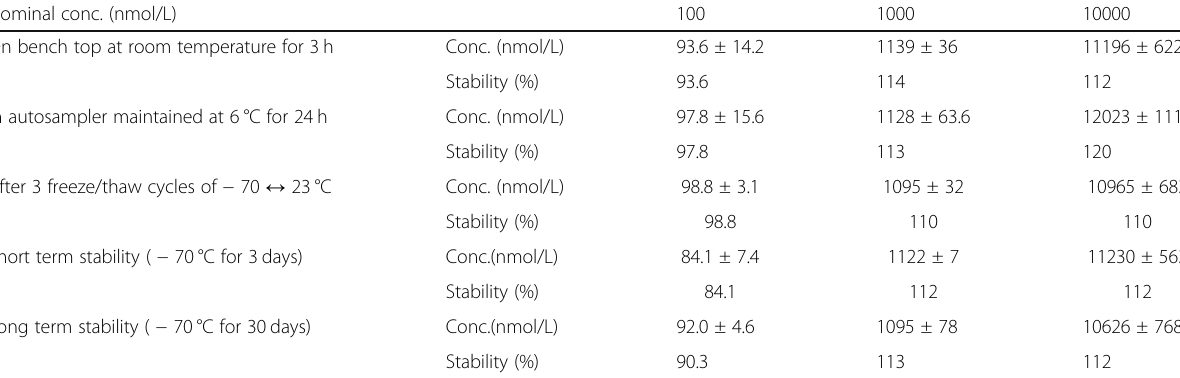
Table 4 Stability data for bromophenol-thiosemicarbazone hybrid in rat plasma (n = 3). Nominal conc. (nmol/L)